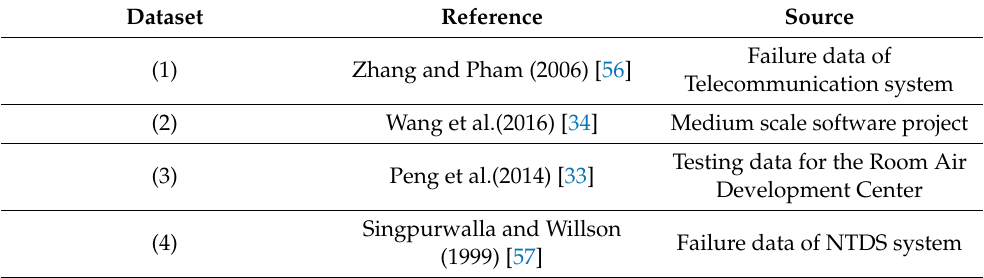
Table 2. The Information for the Datasets.